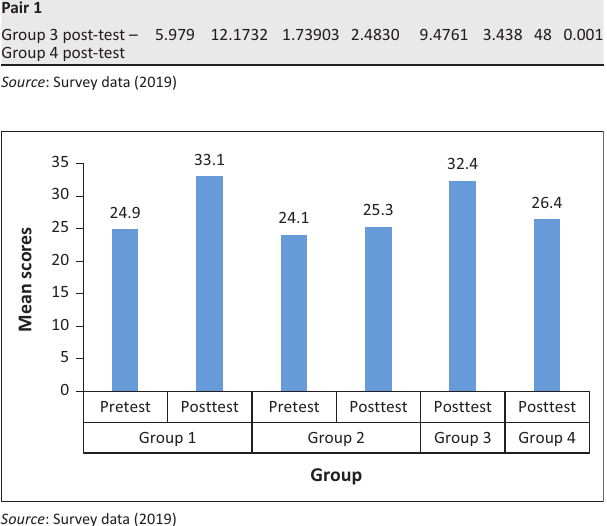
Source : Survey data (2019) * Significant at 5 % level; ** significant at 1 % level.